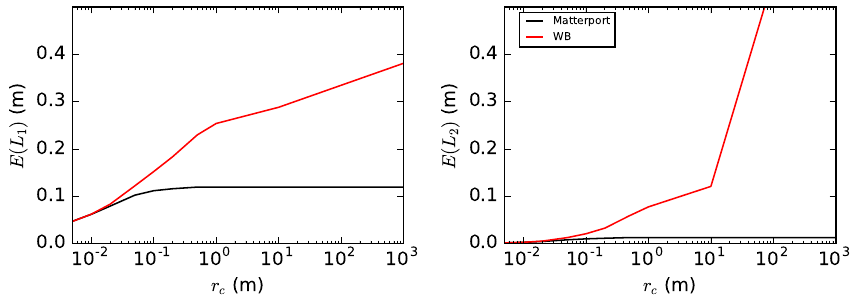
Figure 17. Startup Sauna test site. The error metric E , using L1 ( left ) and L2 ( right ) norms, as a function of the nearest point cut-off distance r c . For the Würzburg backpack (red line), in contrast to Matterport (black line), E rises as an effect of